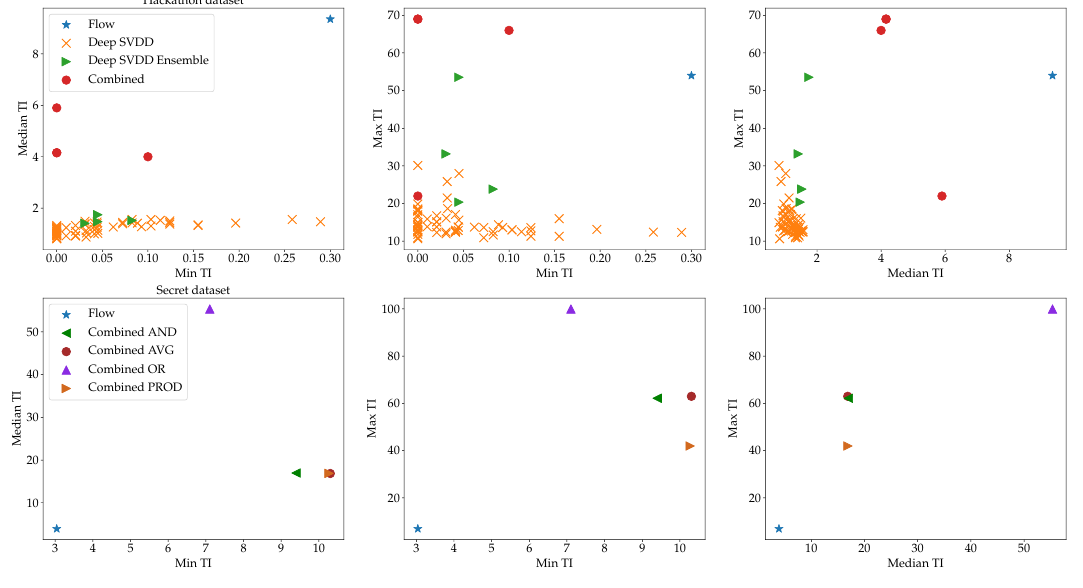
Figure 5: Minimum, median and maximum Total Improvement for the different mod- els tested on the hackathon test set (top row) and the secret set (bottom row). On the secret set the combined model with the OR combination algorithm generally out- performs all other